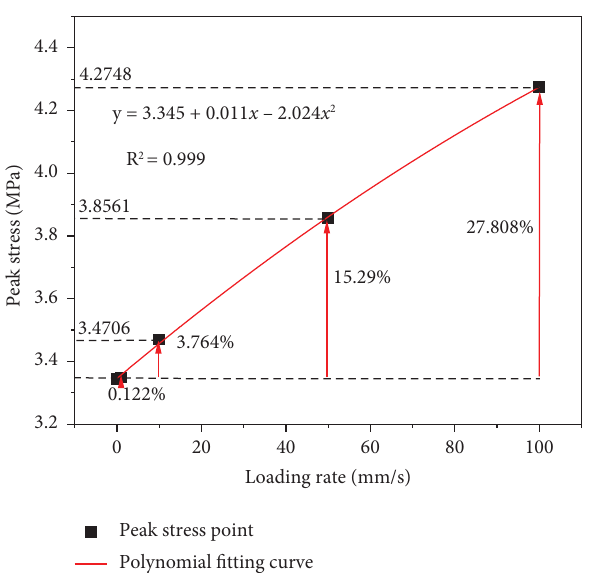
Figure 4: Peak stress change curve of the backfll